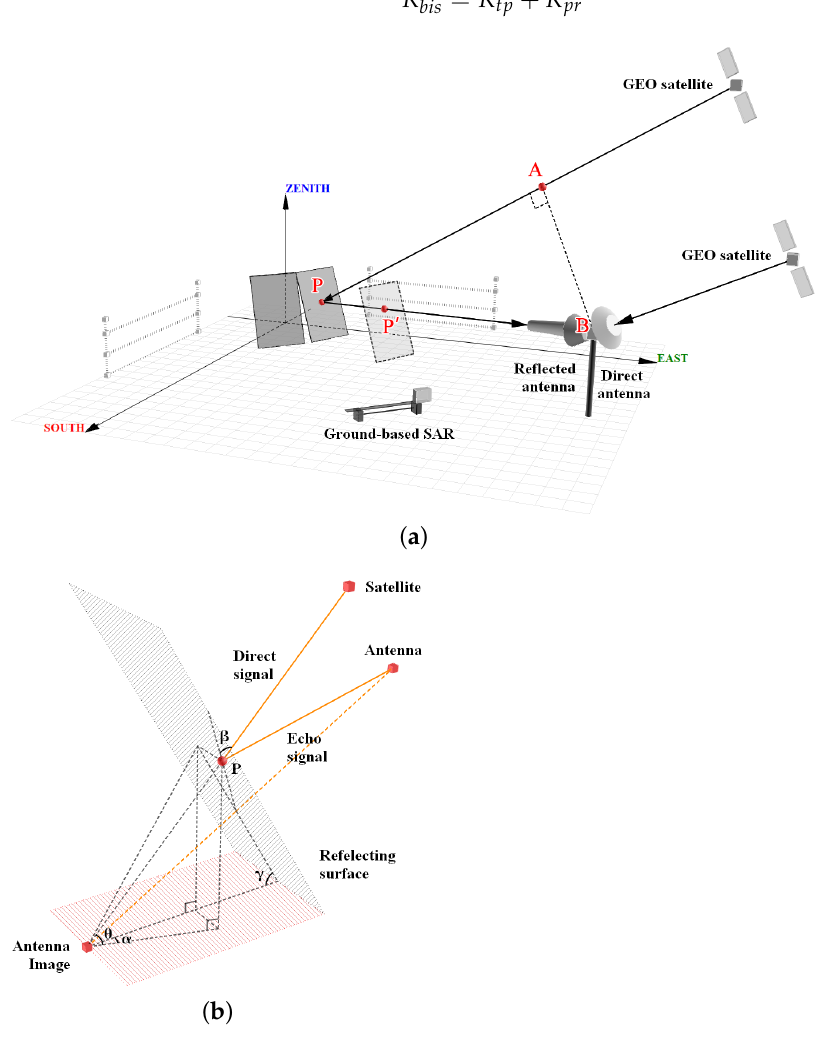
Figure 1. ( a ) Geometry of bistatic GNSS radar system based on geostationary earth orbit (GEO) satellites. ( b ) Reflection path